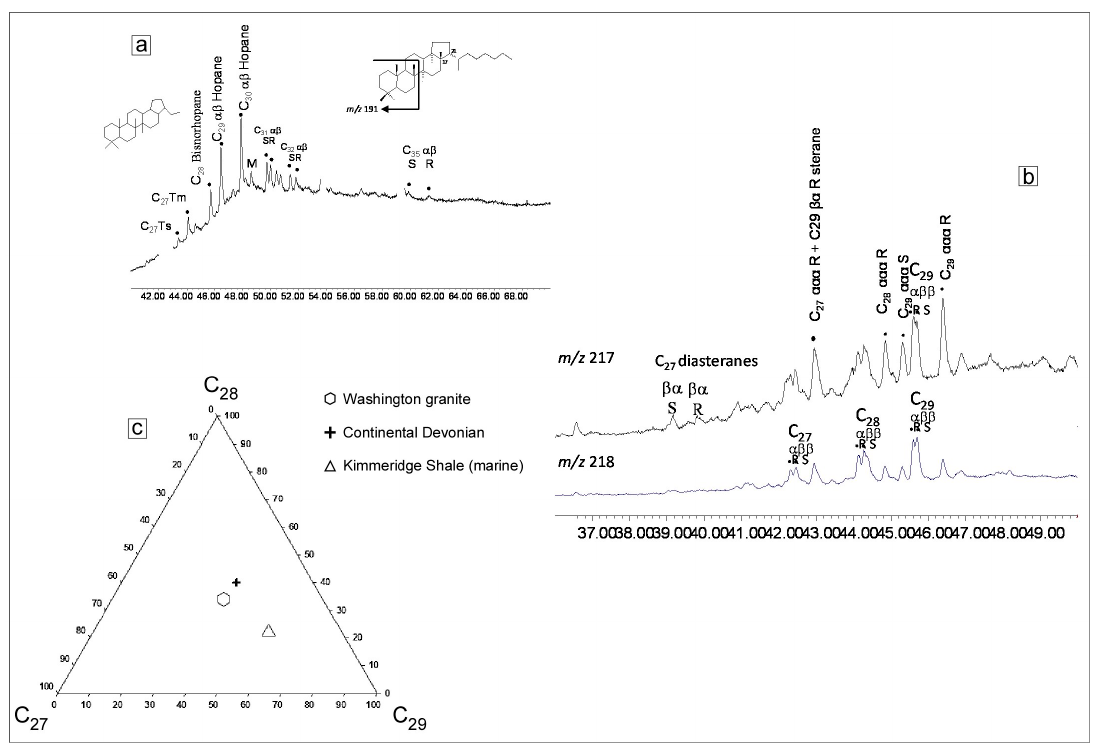
Figure 7. ( a ) Portion of m / z 191 chromatogram from extract of brownish-yellow oil, showing distribution of hopanes; ( b ) Portion of m / z 217 and 218 chromatograms from extract of oil, showing distribution of steranes; ( c ) Ternary plot of relative proportions of C 27 , C 28 and C 29 steranes in the oil sample. Compositions for samples of known continental and marine origin (continental Devonian and marine Jurassic shale, North Sea) plotted for comparison.